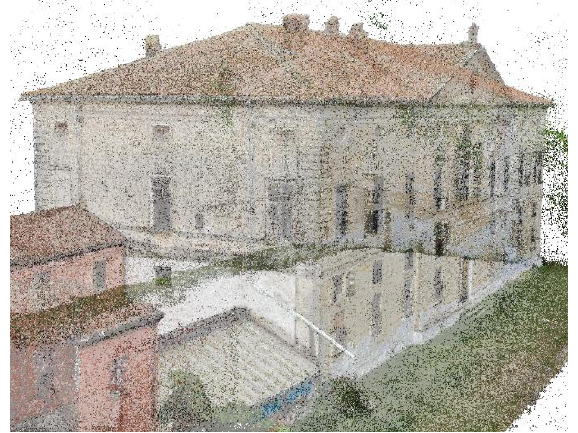
Figure 3. Detail of the site plan, developed in 1905.